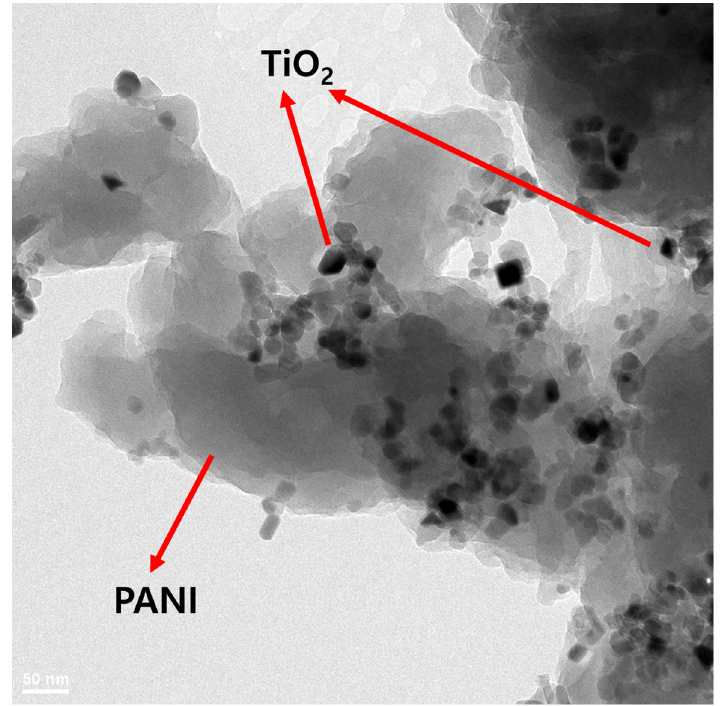
Figure 3. Field-emission transmission electron microscope (FE-TEM) image of PANI/TiO 2 composite.